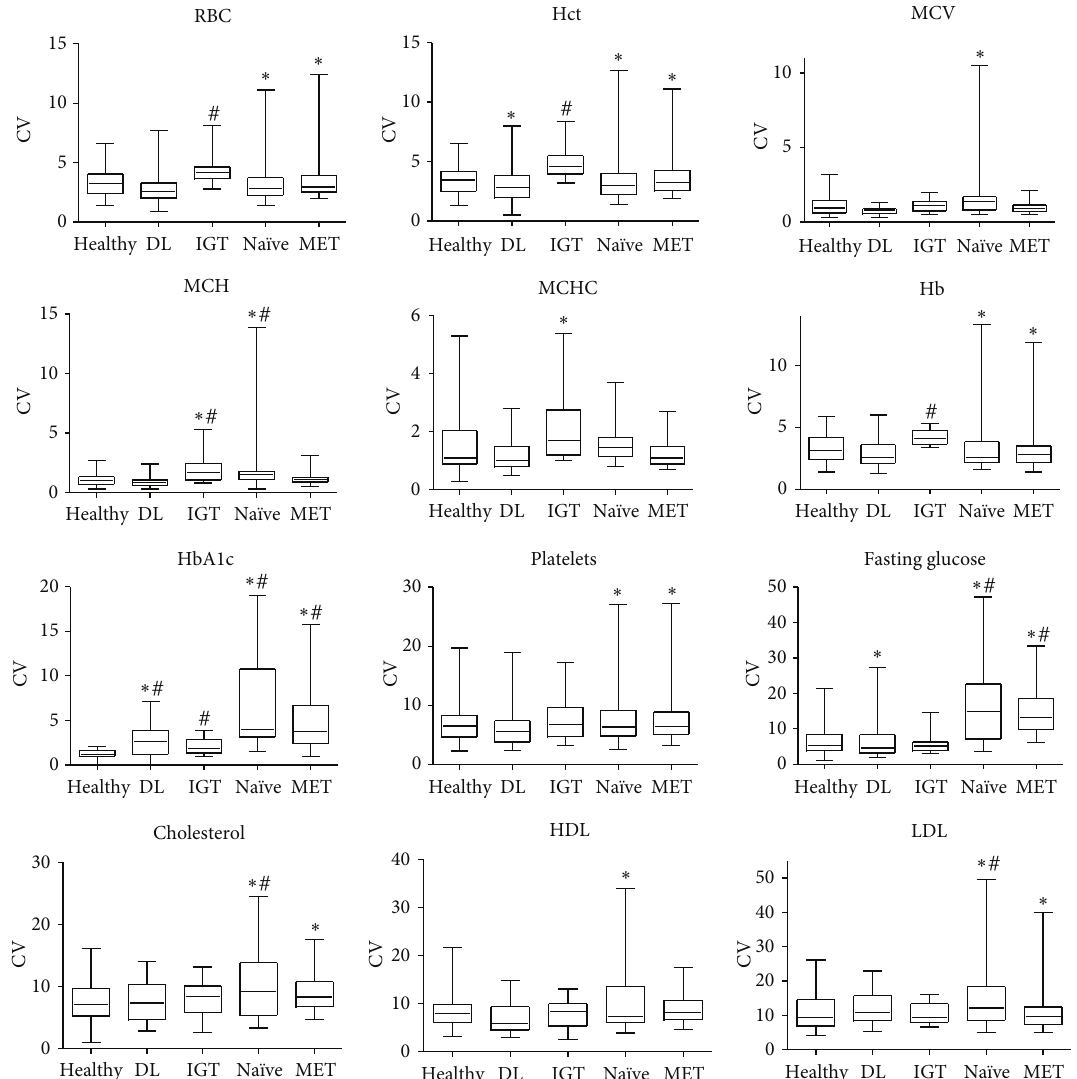
F 2: Coefficients of variation for individual subject hematology and chemistry values in placebo comparisons. DL: dyslipidemic placebo group, IGT: impaired glucose tolerant placebo group, Naïve: treatment-naïve uncontrolled T2DM placebo group, MET: uncontrolled T2DM placebo group on a stable dose of metformin, Hb: hemoglobin, Hct: hematocrit, RBC: red blood cell count, MCV: mean cell